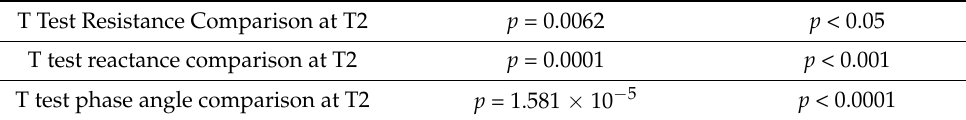
Table 9. T test significance values for cyclotron vs. acupuncture at